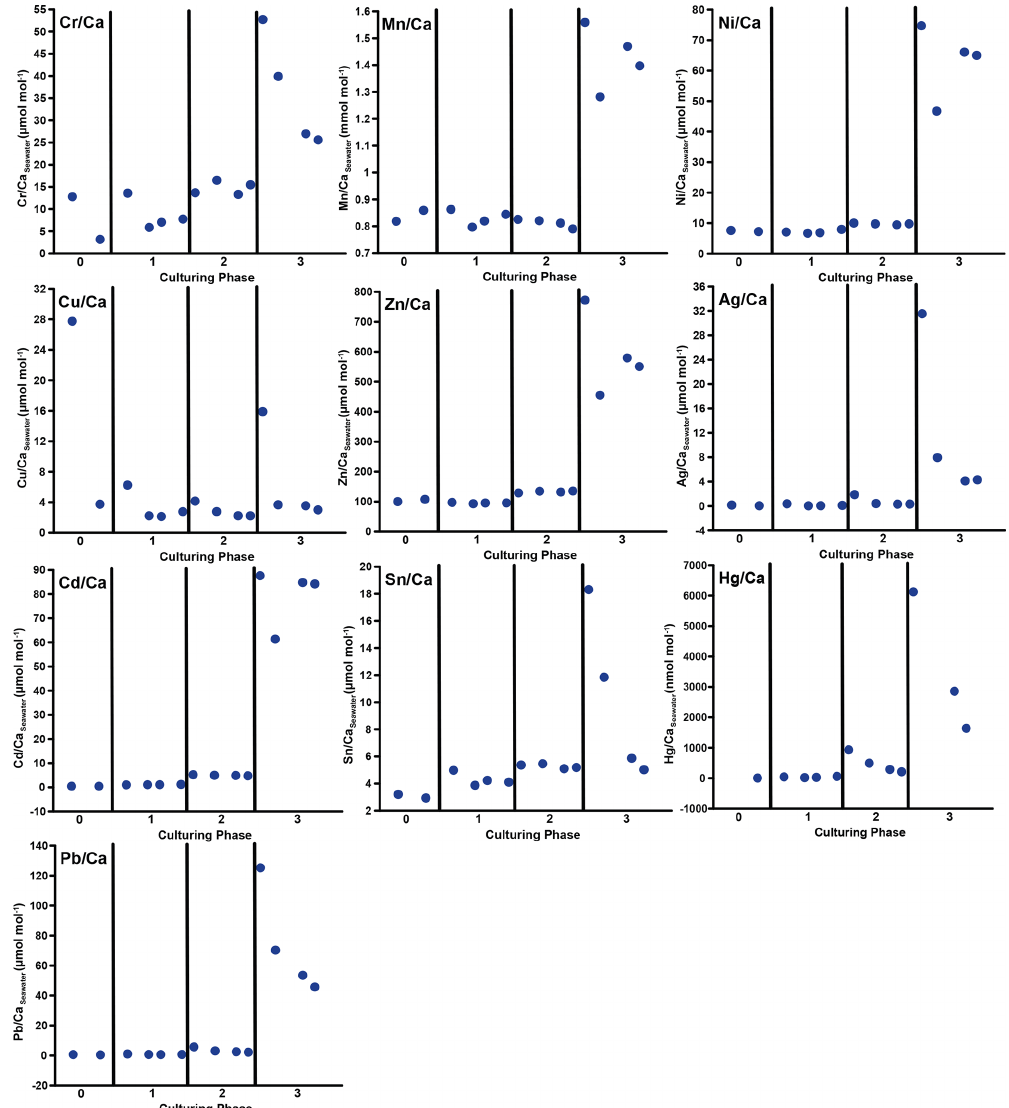
Figure B1. TE / Ca values in the culturing medium of the metal system in µmolmol − 1 or nmolmol − 1 divided by individual culturing phases. In this system, phase 0 is the control phase without any extra added metals, and for phase 1 to 3, the heavy metal concentration in the culturing medium was elevated. The data the figure is based on can be found in Table